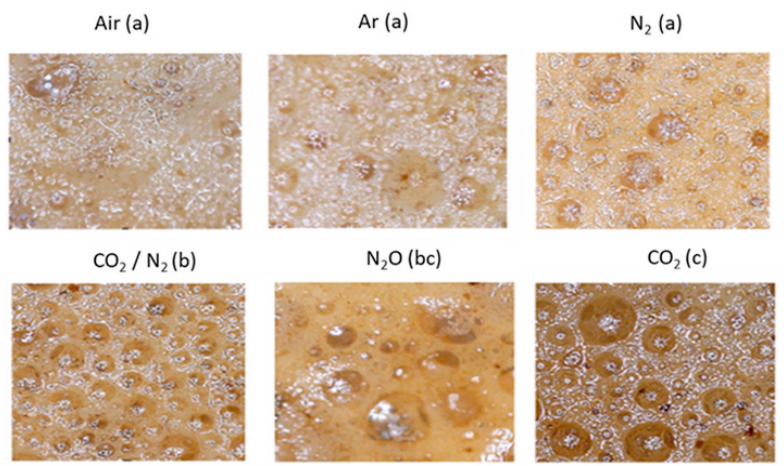
Figure 2. Images of Caffè Firenze espresso foam obtained with the six gases. Different letters indicate statistically significant differences ( p < 0.05 Tukey’s Test).